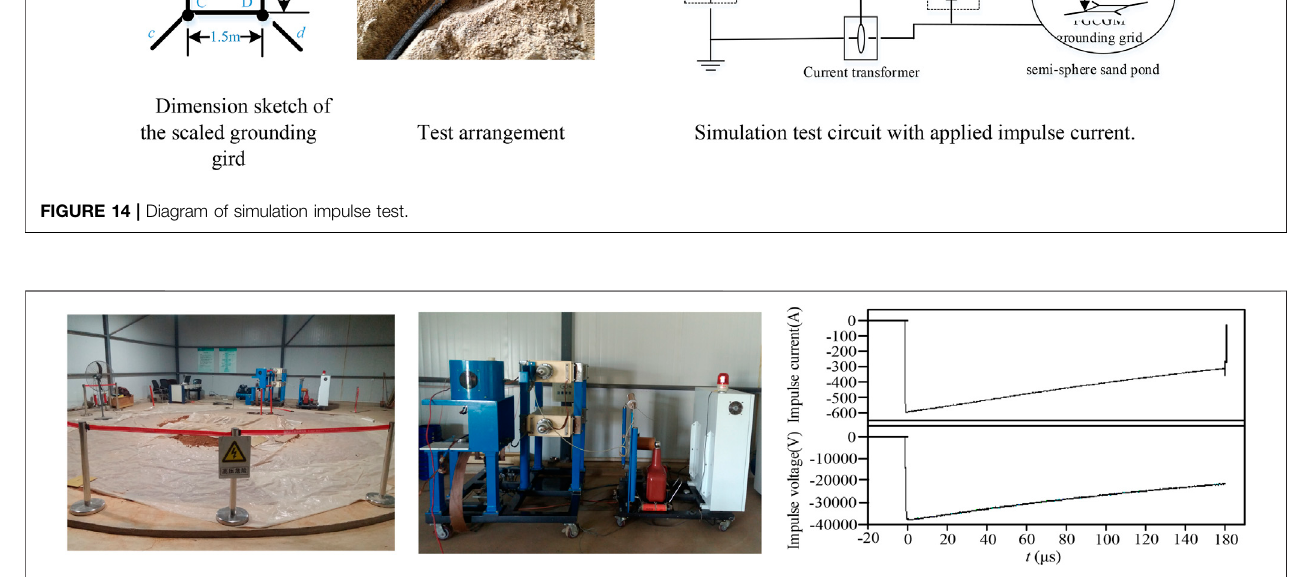
still occurs on FGCGM under a current of high amplitude. This is similar to metal material. The spark discharge effect is bene fi cial to evacuate lightning current and fault current.